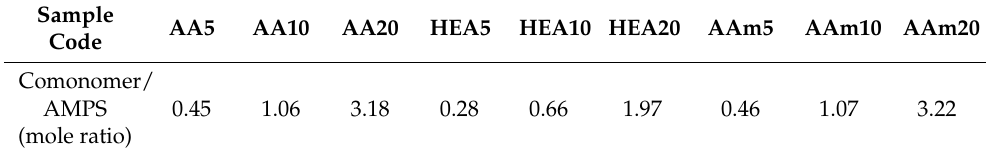
Table 2. Molar ratio of comonomer to AMPS in each